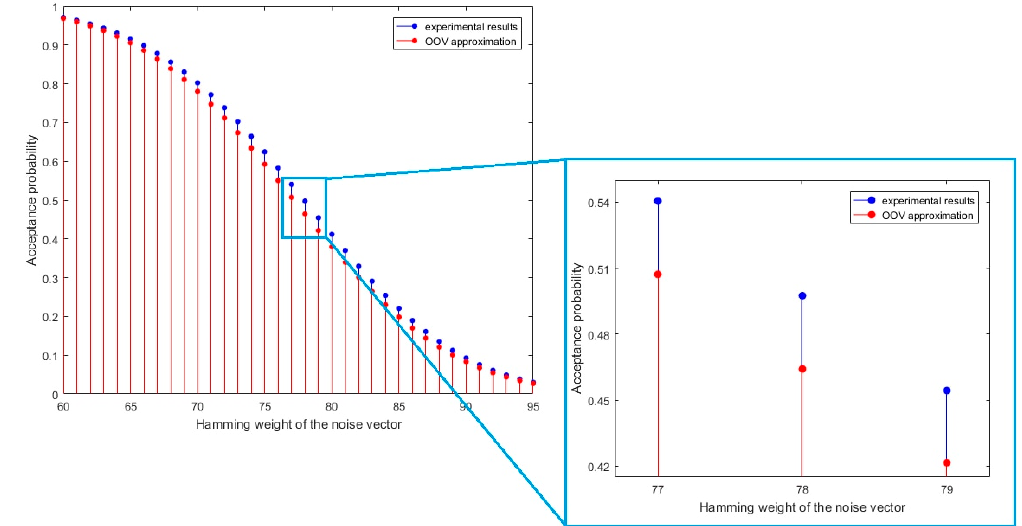
Figure 6. Divergence between the OOV approximation and the experimental results of the acceptance rates for the noise vectors with the Hamming weight between 60 and 95. The detected divergence causes the OOV algorithm to make erroneous weight estimates. Table 2. Difference between the OOV approximation and the experimental acceptance rates for the